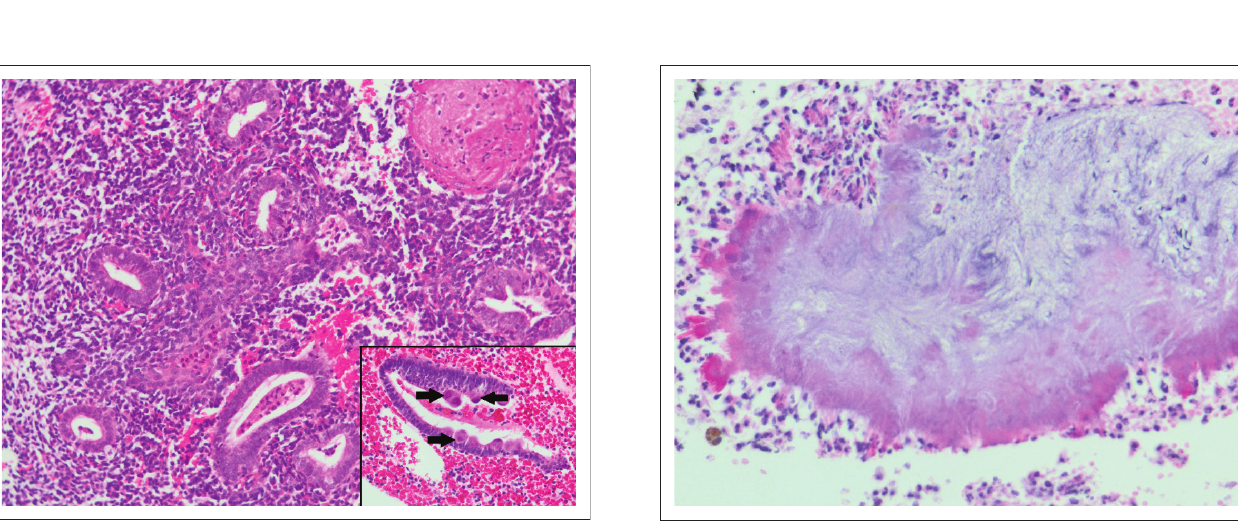
FIGURE 2: Endometrial breakdown and endometritis in an endometrial sample from a 39-year-old patient with abnormal bleeding (original magnification ×200). Cytomegalovirus inclusions in endometrial epithelial cells are indicated by arrows in the inset (original magnification ×400).